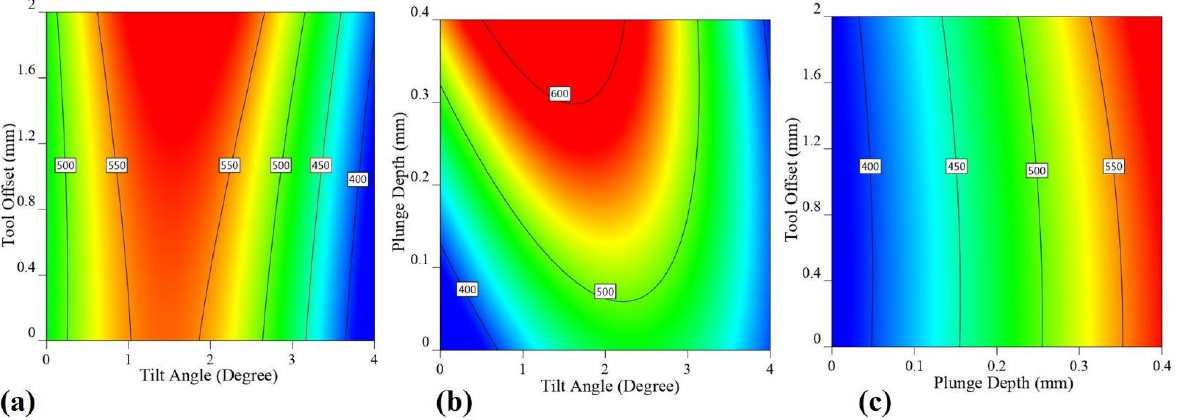
Figure 11. ( a ) Interaction contour of tool offset and tilt angle on the peak temperature, ( b ) interac- tion contour of plunge depth and tilt angle on the peak temperature and ( c ) interaction contour of tool offset and plunge depth on the peak temperature.